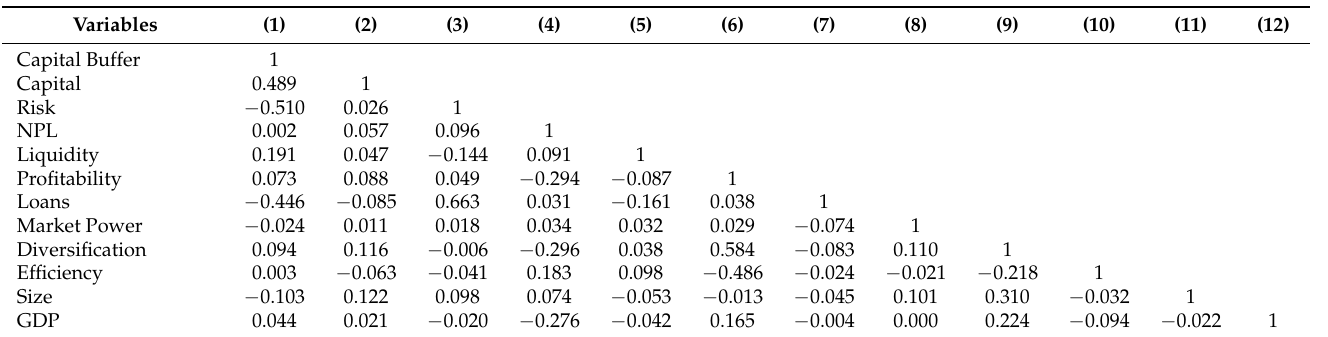
Table 2. Matrix of correlation.